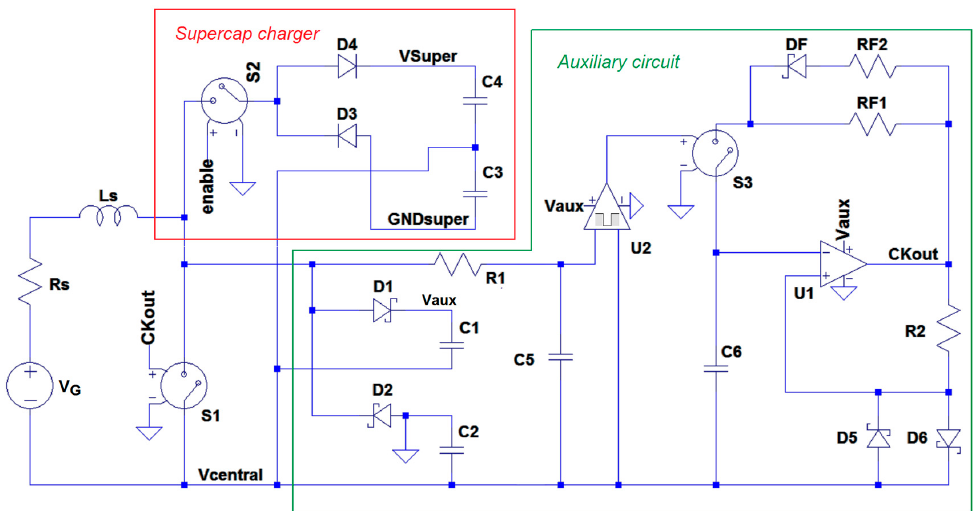
Figure 11. Simplified schematics of the charging circuit.